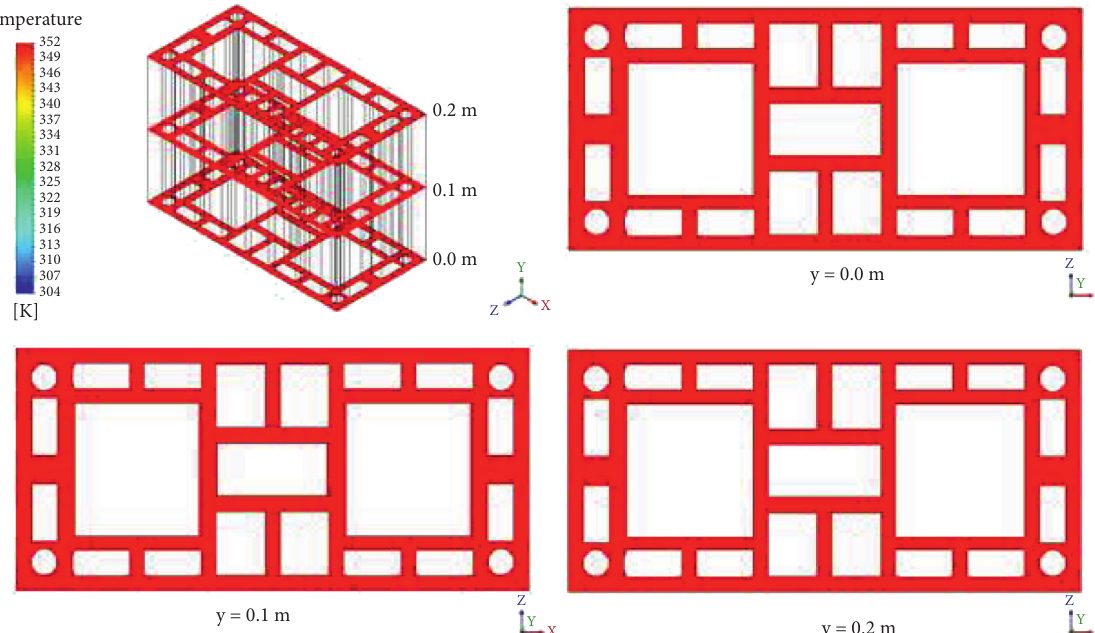
Figure 13: Temperature field inside the brick at different XZ planes, with the elapsed time of 15.5 hours ( T � 80 ° C, RH �